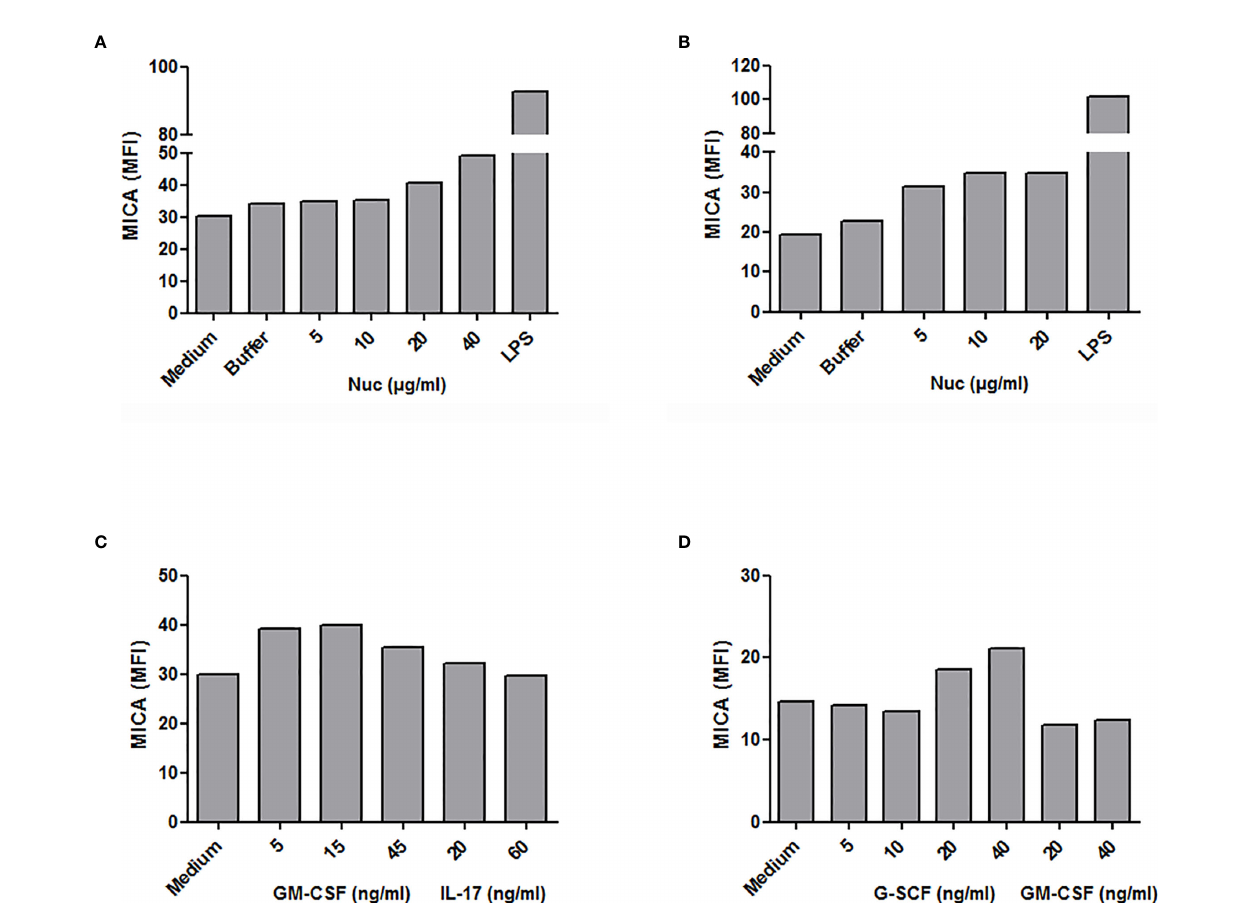
FIGURE 5 | Modulation of plasma membrane MICA expression in monocytes and neutrophils. PBMC, monocytes or PMN were stimulated in vitro with puri fi ed mono-nucleosomes (Nuc), cytokines or lipopolysaccharides (LPS) and MICA expression was analyzed by fl ow cytometry. (A) PBMC were used and monocytes were gated. (B, C) Enriched monocytes. (D) Isolated PMN. In each panel, shown is one representative experiment of at least three independent experiments using cells from independent donors and independent nucleosome preparations. MFI, mean fl uorescence intensity; Buffer, buffer used for nucleosome puri fi